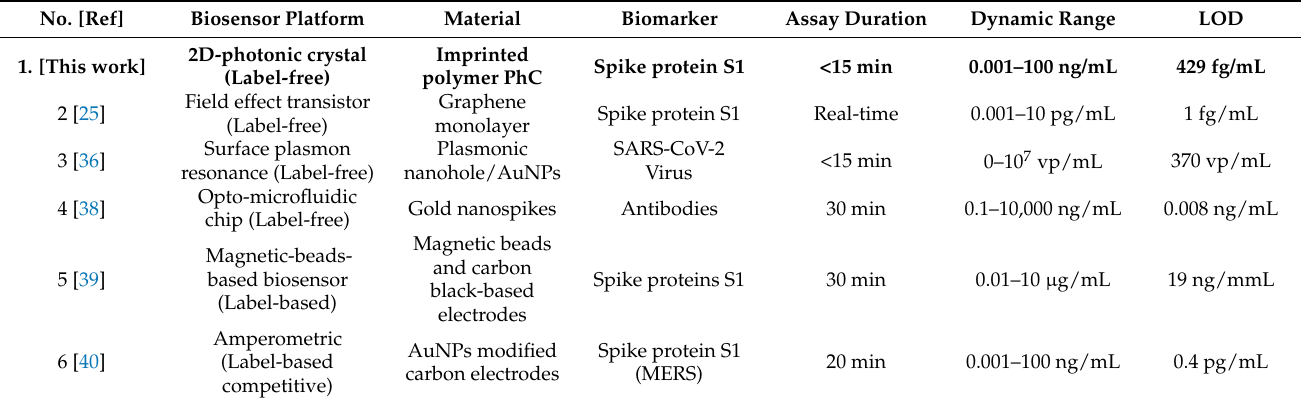
Table 1. Comparison of nanomaterial-based immunosensors for Coronavirus